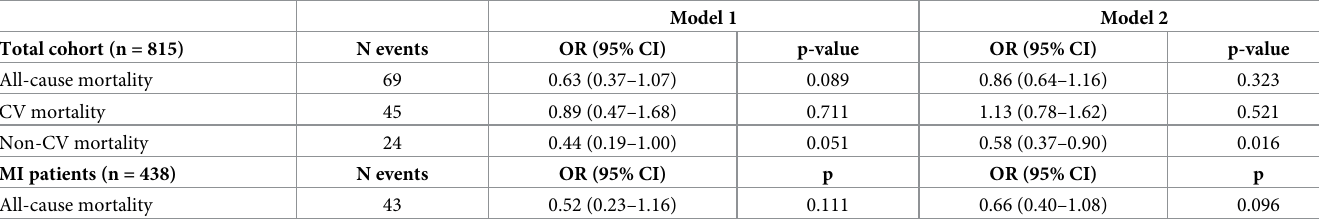
Table 4. Prognostic evaluation—Association of the hs-cTn I/T ratio (ln) with 1-year